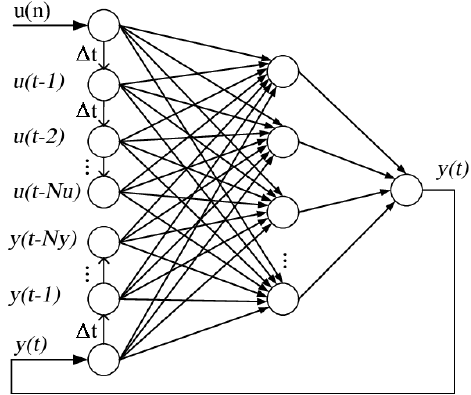
Figure 8. NARX scheme using a neural